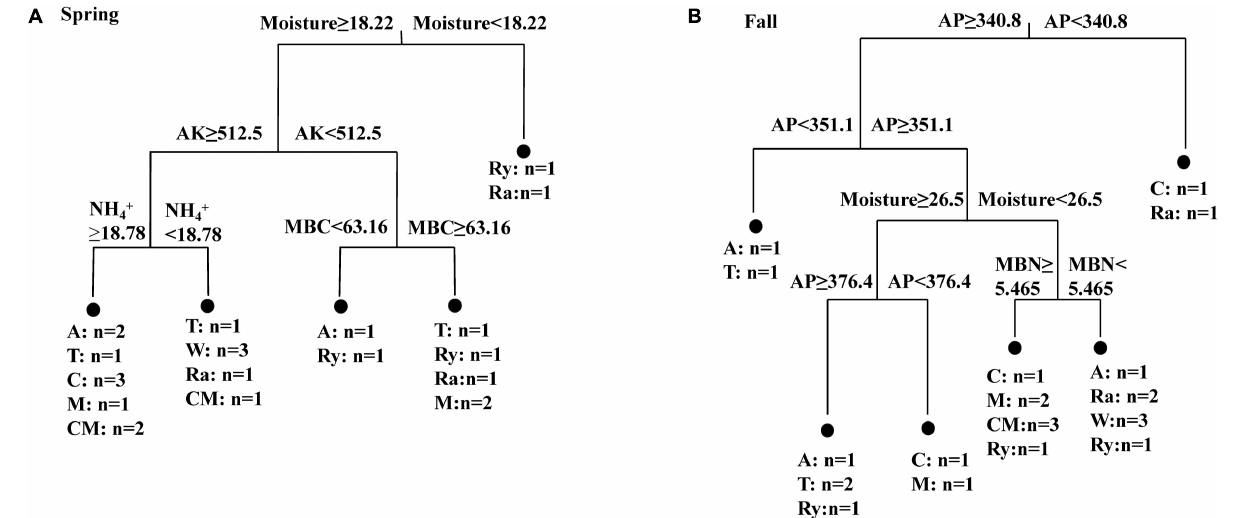
Frontiers in Microbiology |